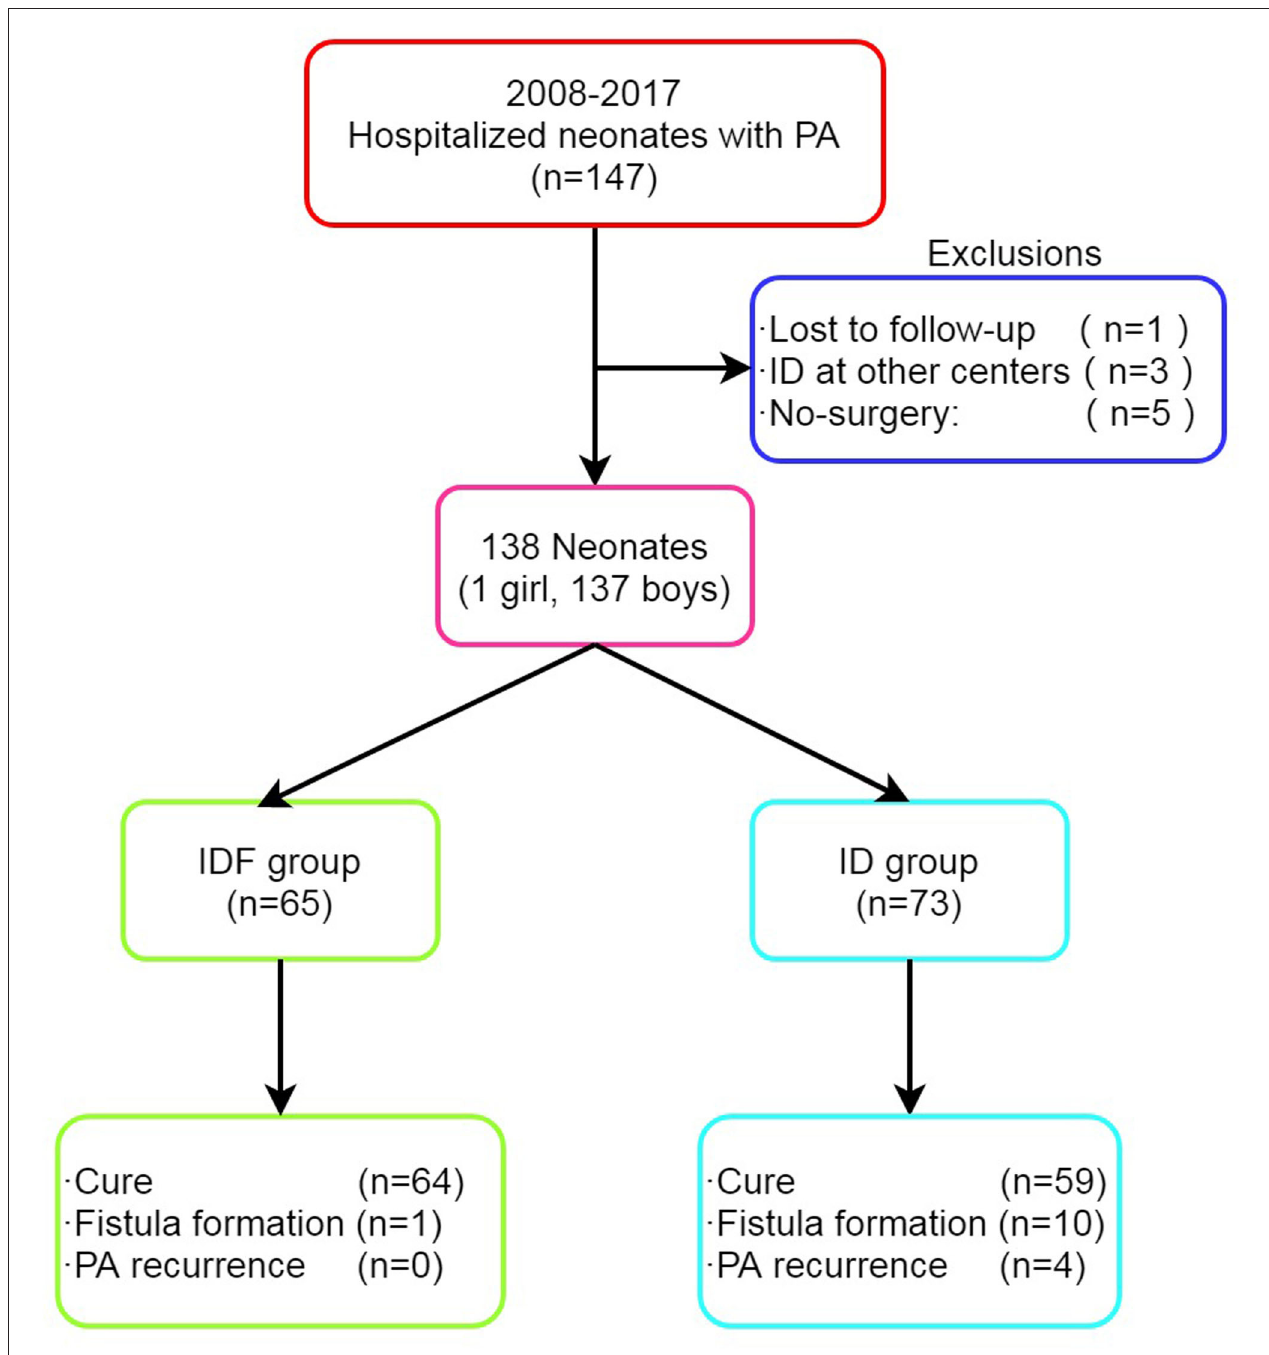
FIGURE 1 | Enrollment, treatment, and long-term outcomes of patients with PA. PA, perianal abscess; ID, incision and drainage; IDF, incision and drainage with primary fistulotomy.